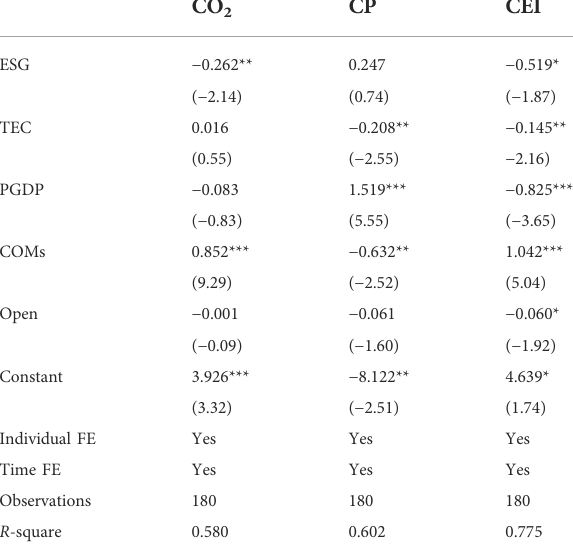
TABLE 6 The effect of ESG total investments on carbon